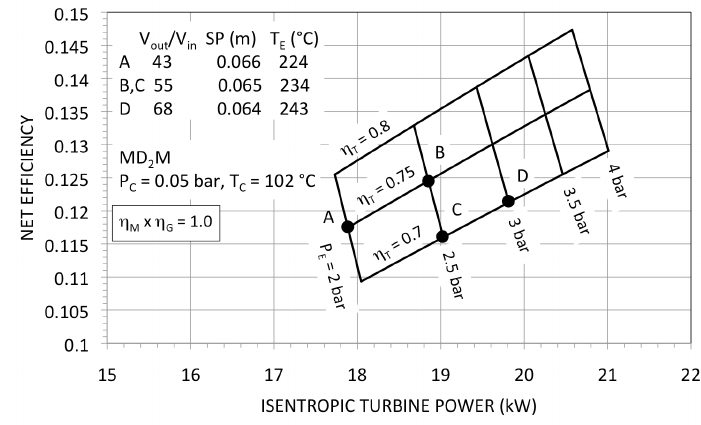
Figure 5. Net cycle efficiency and isentropic turbine power for MD 2 M. The condensation pressure is fixed at 0.05bar. The parameter η T represents the efficiency of a one-stage axial